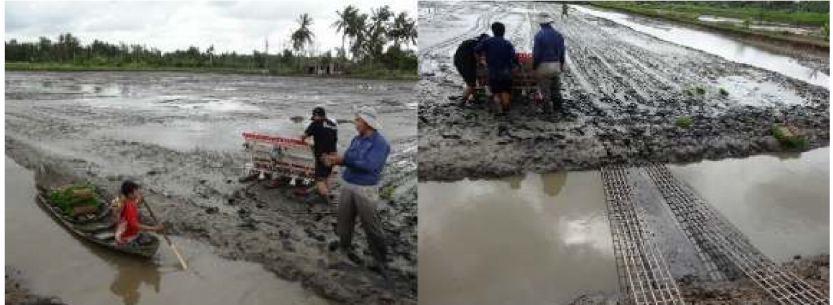
Figure 4. Machine transplanting at a wet and muddy field in a Ca Mau province one-crop area (rice and shrimp farming area). The paddy field is surrounded by water where farmers grow shrimp. Rice seedlings are brought by a boat. Source: Photos taken by the author at U Minh, Ca Mau on 11 August